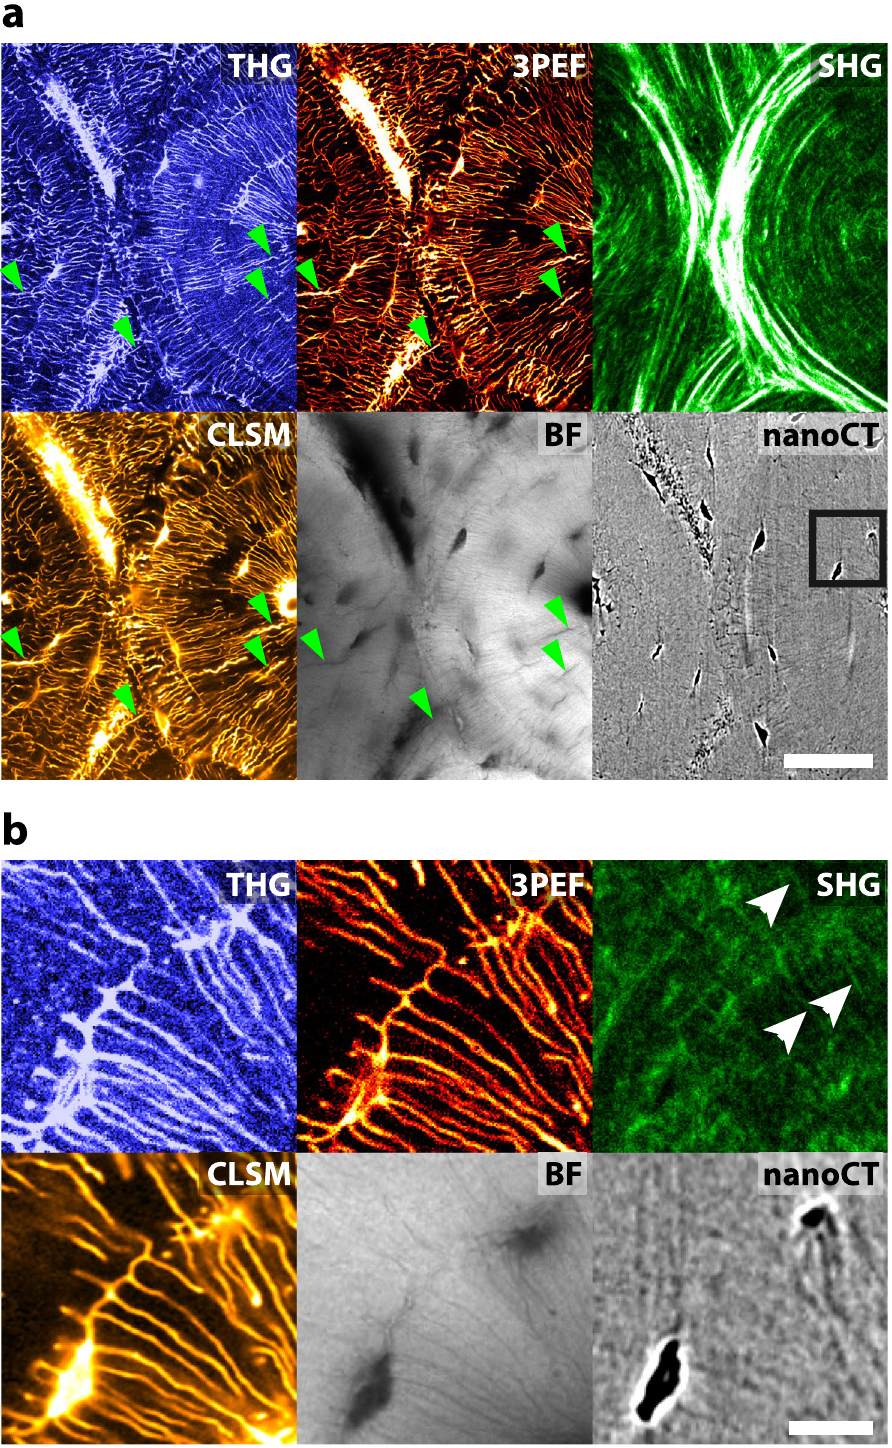
Figure 3. Comparison of different bone imaging modalities. ( a ) Wide field comparison of THG (top left), 3PEF (top middle), SHG (top right), fluorescence confocal (CLSM, bottom left), brightfield transmission (BF, bottom middle) and X-ray nanoCT (bottom right) images acquired on a transverse section of a bovine femur. Some cracks are indicated by green arrowheads in ( a ). Additional cracks are visible on the confocal and brightfield images that were recorded after the nonlinear images. Scale bar, 50 µ m. ( b ) Zoom in the black rectangle in ( a ). Collagen fibrils along some of the canaliculi are shown by white arrows on the SHG image. Scale bar, 10 µ m. See also Supplementary Movie 3 and